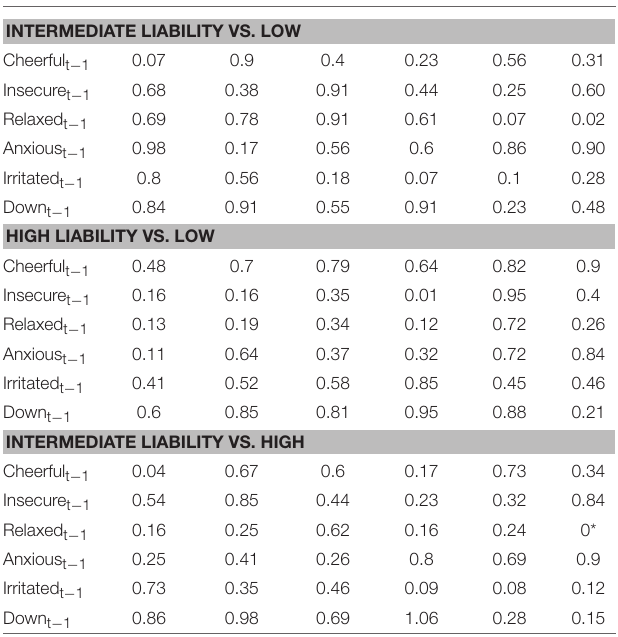
TABLE 3 | Comparison between regression coefficients in the three genetic liability strata ( p -values presented were obtained from permutation tests of between group differences, Simes corrected alpha =